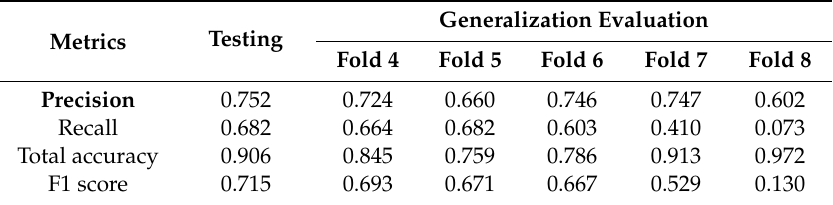
Figure 11. The winter wheat growing season in the Huanghuaihai Region, ( a ) sowing; ( b ) overwintering; ( c ) green-returning; ( d ) jointing; ( e ) flowering; ( f ) maturation. The cell values of the raster map represent the day of the year on which winter wheat enters the growing stage. Contour lines are shown on the map. The first two maps show the growing times in 2017, and the others show the growing times in 2018. Table 6. Generalization performance scores of the RF